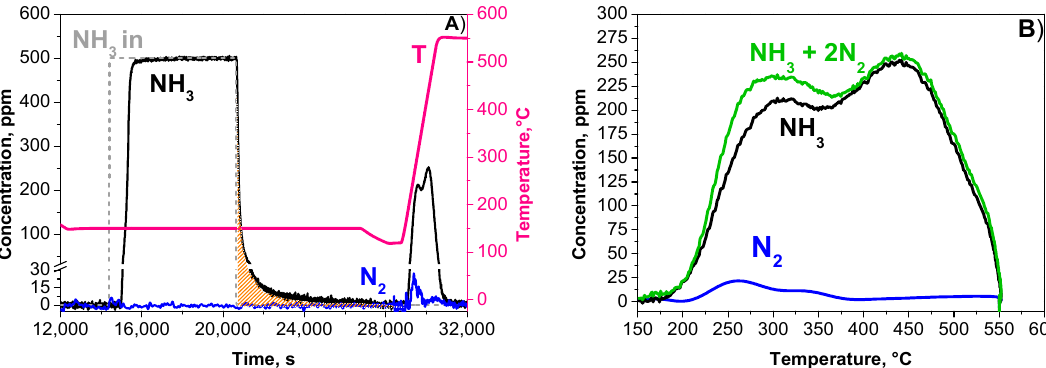
Figure 1. ( A ) NH 3 adsorption + TPD test over 1.7Cu-CHA 25 catalyst. GHSV = 266,250 cm 3 /(g cat *h) (STP). Pre-oxidized catalysts. NH 3 = 500 ppm, TPD heating rate = 15 °C/min, He. ( B ) TPD plot.